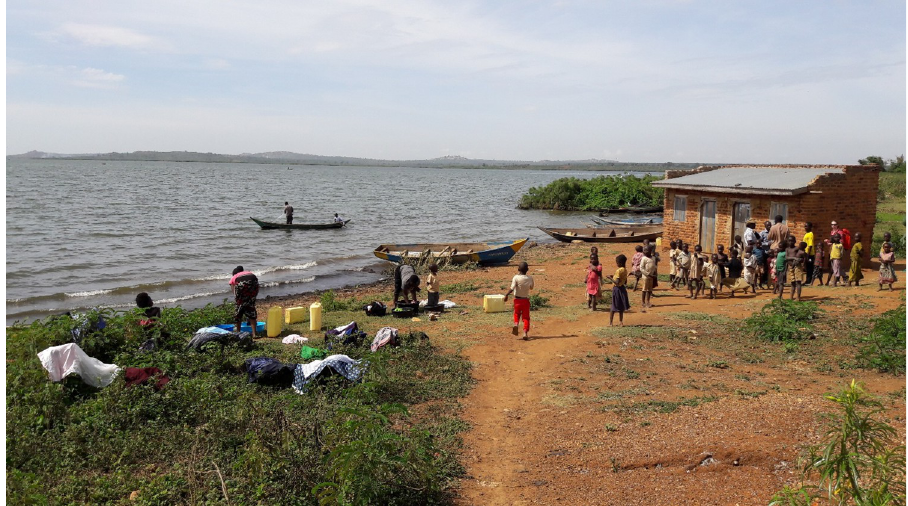
Fig 6. Social activities performed at the